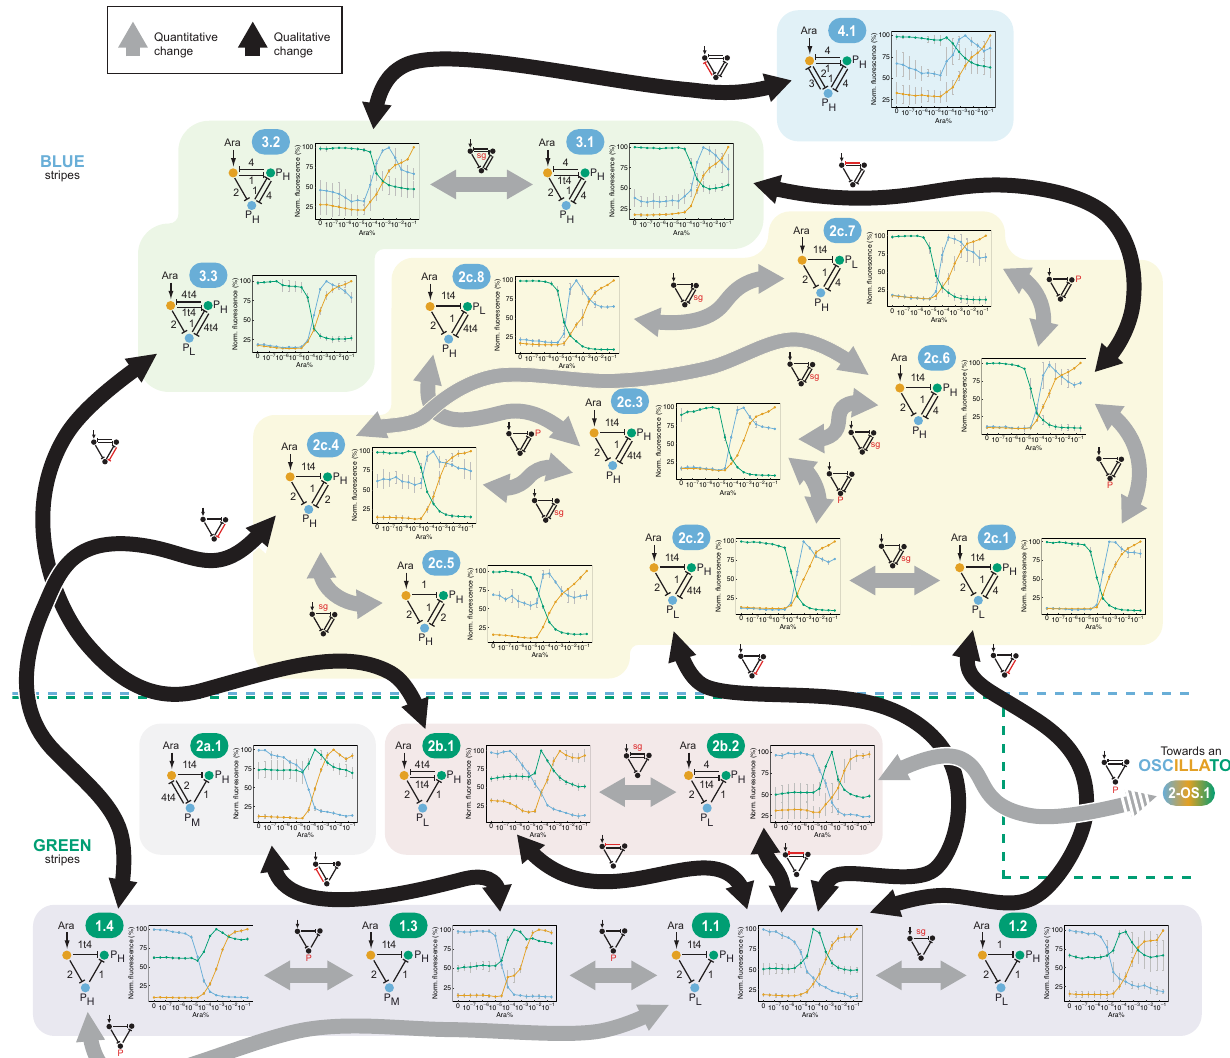
Fig. 2 | A synthetic genotype network of GREEN-stripe (bottom) and BLUE- stripe (top) GRNs. Starting from a CRISPRi-based GREEN-stripe incoherent feed- forward loop (IFFL-2, design 1.1), we introduced quantitative (gray) or qualitative (black) changes to produce a genotype network of synthetic GREEN-stripe GRNs. Single changes enabled the transition from GREEN-stripe GRNs to BLUE-stripe GRNs. We then explored this BLUE-stripe genotype network through parameter (gray) or topology (black) changes, up to the GRN with the maximum number of repressions for a 3-node GRN without self-repression, GRN 4.1. Dashed lines representtheboundariesofthe GREEN-stripeandBLUE-stripe genotypenetworks. Each design is denoted with a unique code displayed in an ellipse (color-coded according to the phenotype), with the details of the design provided in the dia- grams below. The GRN code denotes both the complexity (i.e. number of interac- tions) and the topology, as well as the speci fi c implementation. A higher starting number of the GRN (e.g. 2 vs. 1) re fl ects an increased complexity, while different